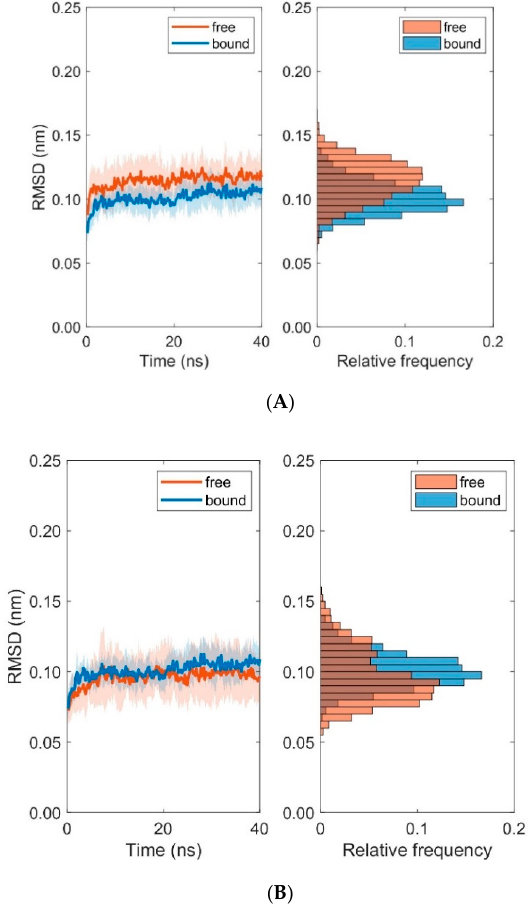
Figure 10. Time course and distribution of RMSD-values for domains TCR V α ( A ) and TCR V β ( B ). Time-series (left panels, mean ± SD) and histograms (right panels) display pooled RMSD-values from ten 40 ns MD simulations each for bound and unbound (free)